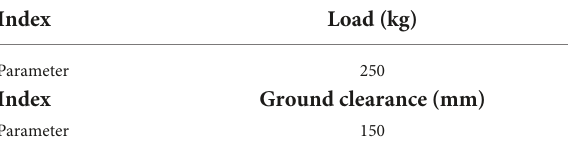
TABLE 2 Chassis hardware structure parameters.